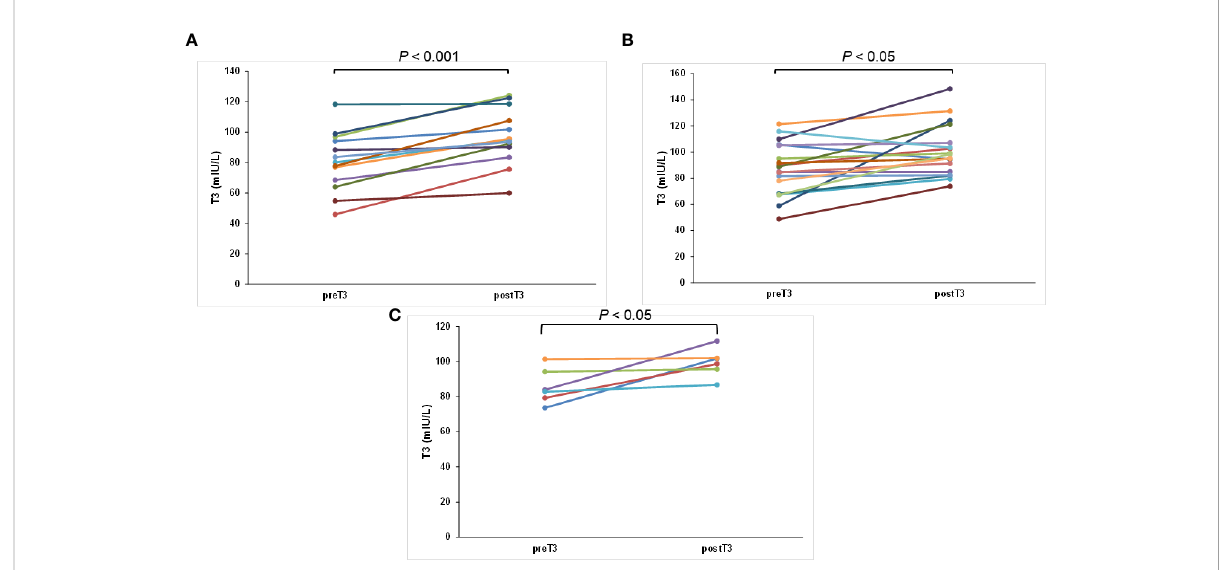
FIGURE 2 The change in T3 concentration for each patient after swallowing the tablet with water and postponing coffee/tea at least 4 h later: (A) only coffee, (B) only tea, and (C) both coffee and tea